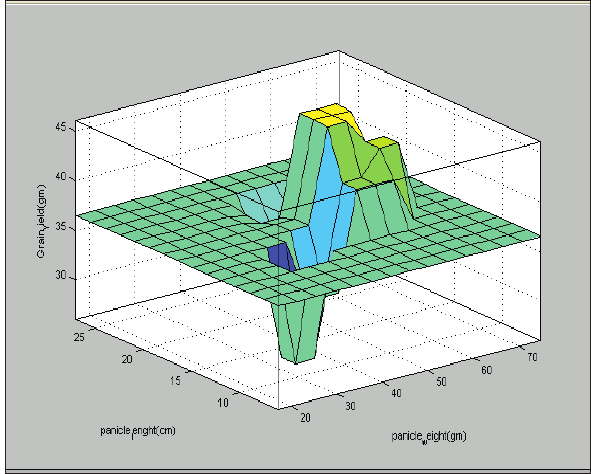
Figure 6. 3D view of three-to-one mapping (panicle length, panicle weight, number of